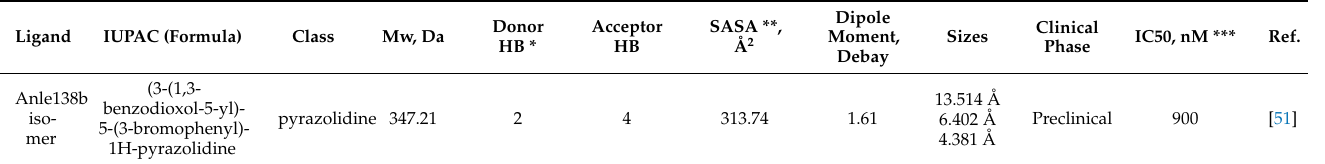
Table 5. Physicochemical properties of the Anle138b isomer.